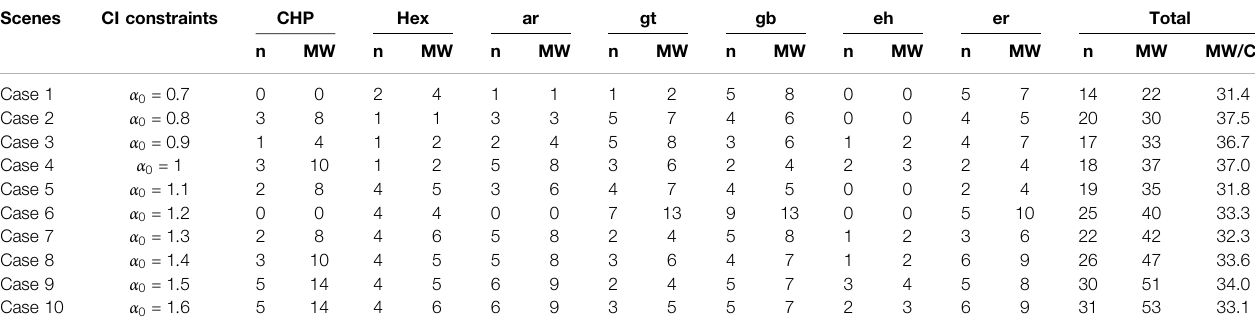
TABLE 8 | Planning results with different CIs. (b) Numbers and capacities of each type of energy conversion device. Scenes